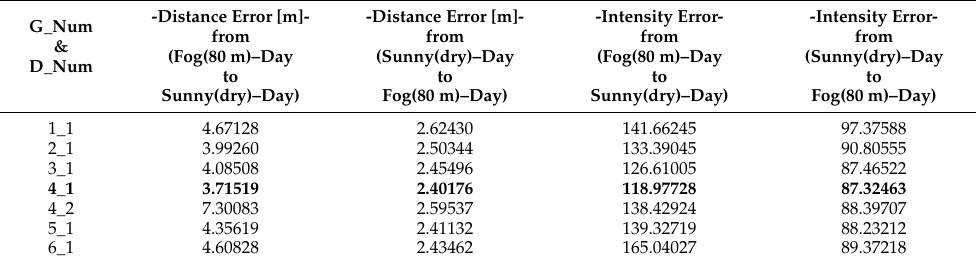
Table 4. Error results depending on the number of ResNet blocks in the generator and discriminator. G_Num and D_Num indicate the number of ResNet blocks in the generator and discriminator, respectively. The numbers in the table indicate the distance and intensity errors. The bold numbers show that the most architecture is four ResNet blocks for the generator and one ResNet block for the discriminator.